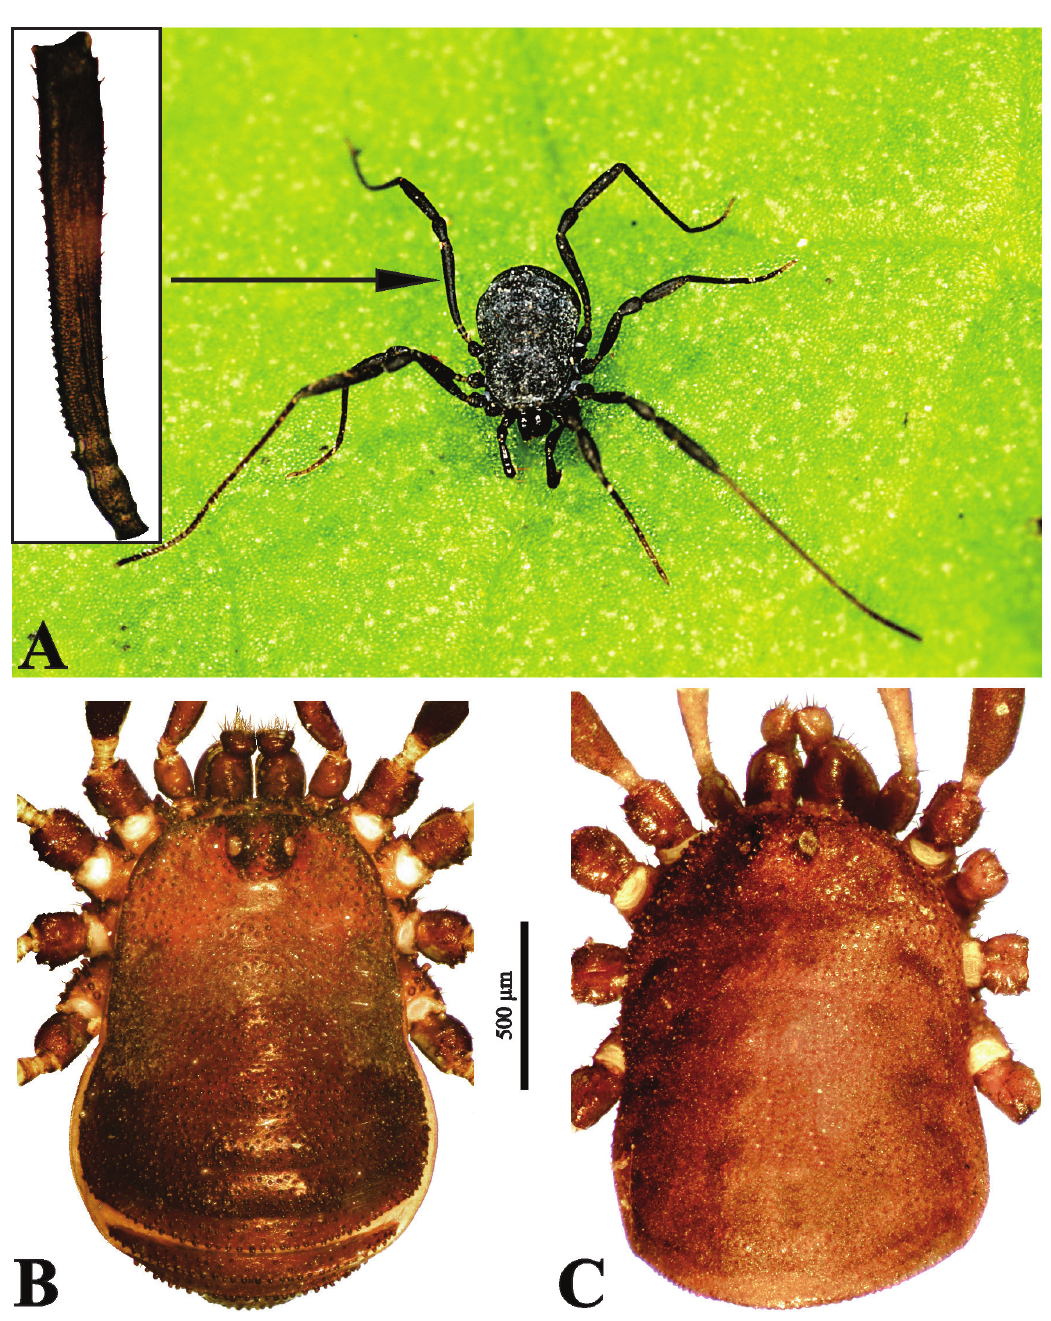
Fig. 1. Representatives of the Nemastoma bidentatum Roewer, 1914 complex. A . The habitus of a male Nemastoma bidentatum gruberi Novak, Slana Novak, Kozel & Raspotnig ssp. nov.; Svete gore, Slovenia (photo: C. Komposch); inset: femur IV with two pseudo-articles (apparent articles, i.e., sections delimited with pale, indented rings on the proximal femur portion), and a saw on the latero-posterior margin. B . The body of a male Nemastoma relictum Gruber & Martens, 1968 stat. nov. showing the tuberculate surface of glittering scutum compositum, and position of the ocular mound (tuber oculorum), supracheliceral lamellae, chelicerae with cheliceral apophysis, and pedipalps and leg. The frontal portion of the scutum is smeared over with a hardened secretum of the integumental glands (cf. Wolff et al. 2016); Mt. Großes Karr, the Koralpen Mts, Austria. C . The body of a male Nemastoma bidentatum gruberi ssp. nov., smeared over with the secretum; Kozje,